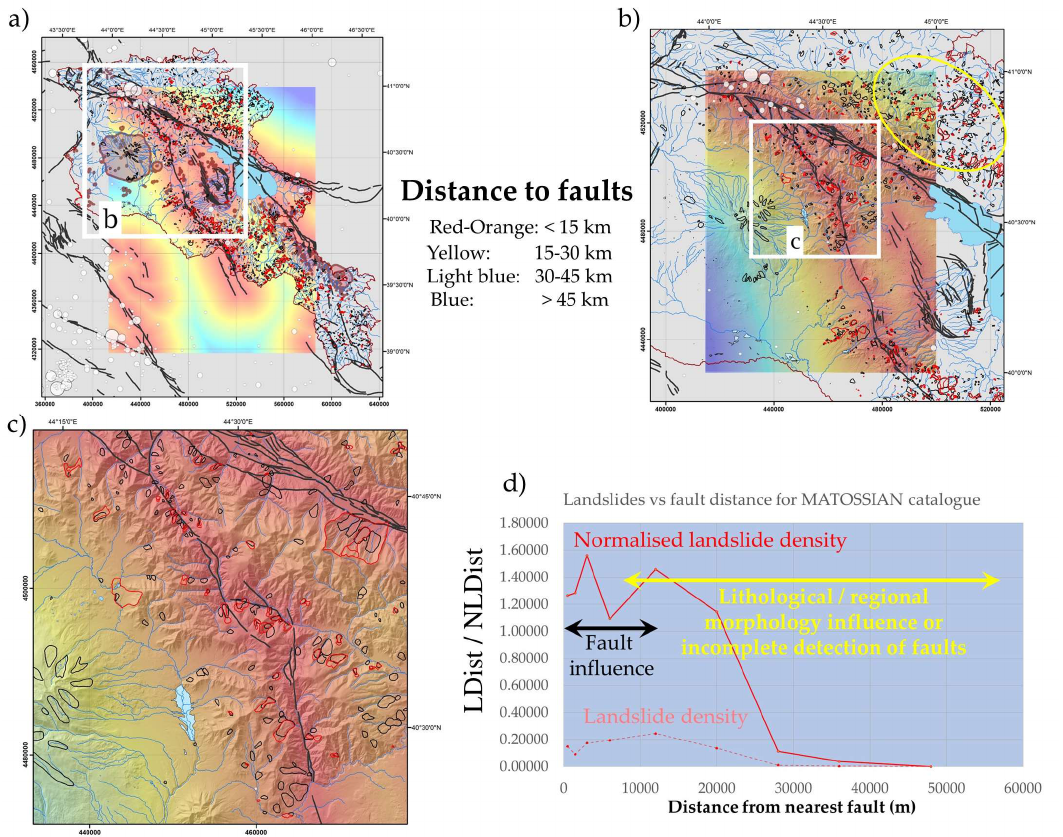
Figure 9. Landslide distribution with respect to their distance to faults. ( a ) General map of Armenia, and enlarged views of ( b ) the northwestern zone and ( c ) the area east of Aragats volcano. The GF (west) and PSSF (east) fault areas are indicated in each map. ( d ) Landslide density (y-axis) as a function of the distance to the nearest active fault: the landslide density LDdist represents the ratio of the landslide areas within a certain distance class (in meters) compared to the entire area covered by mass movements, whereas the normalized landslide density NLDdist represents the same ratio normalized by the ratio of the distance class area divided by the total map area.